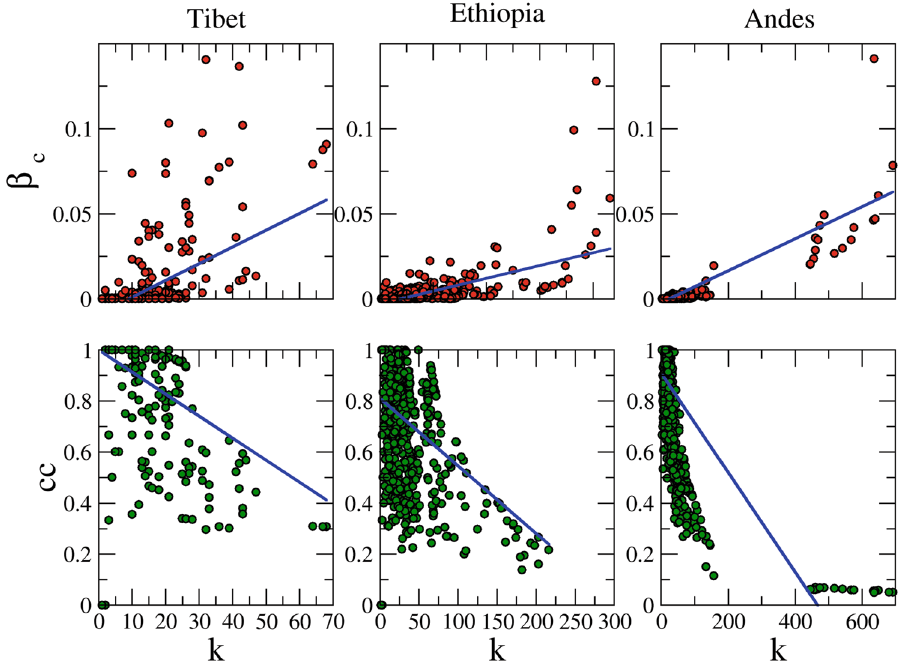
Figure 3. Betweenness centrality (upper panel) and clustering coefficient (lower panel) are plotted as function of degree for all the three